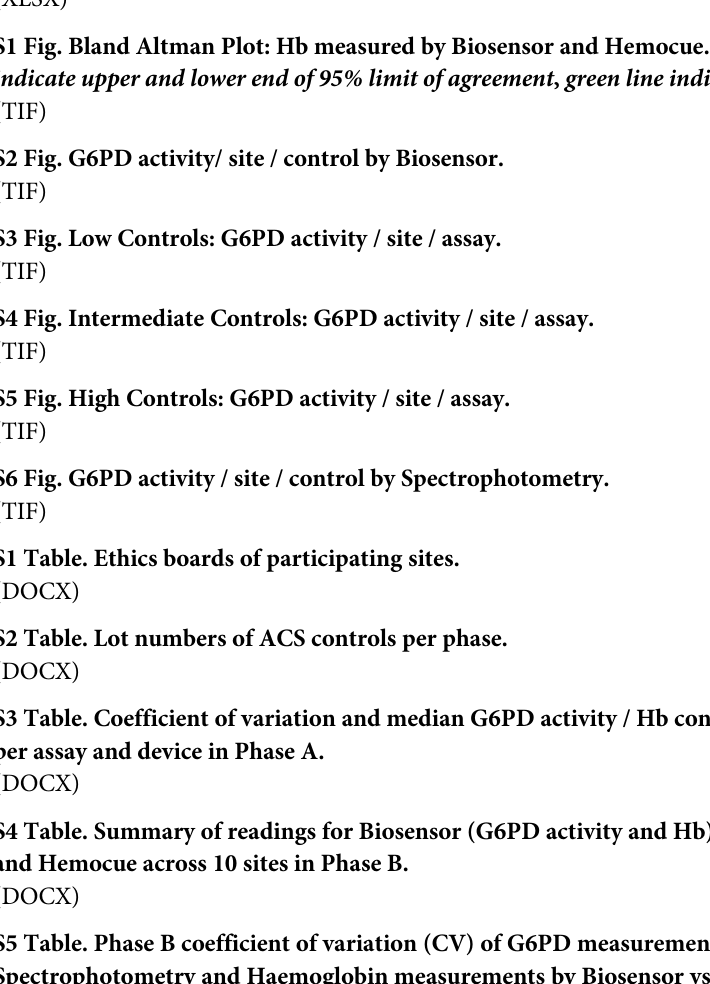
S3 Table. Coefficient of variation and median G6PD activity / Hb concentration measured per assay and device in Phase A. S4 Table. Summary of readings for Biosensor (G6PD activity and Hb), spectrophotometry, and Hemocue across 10 sites in Phase B. S5 Table. Phase B coefficient of variation (CV) of G6PD measurements by Biosensor vs Spectrophotometry and Haemoglobin measurements by Biosensor vs